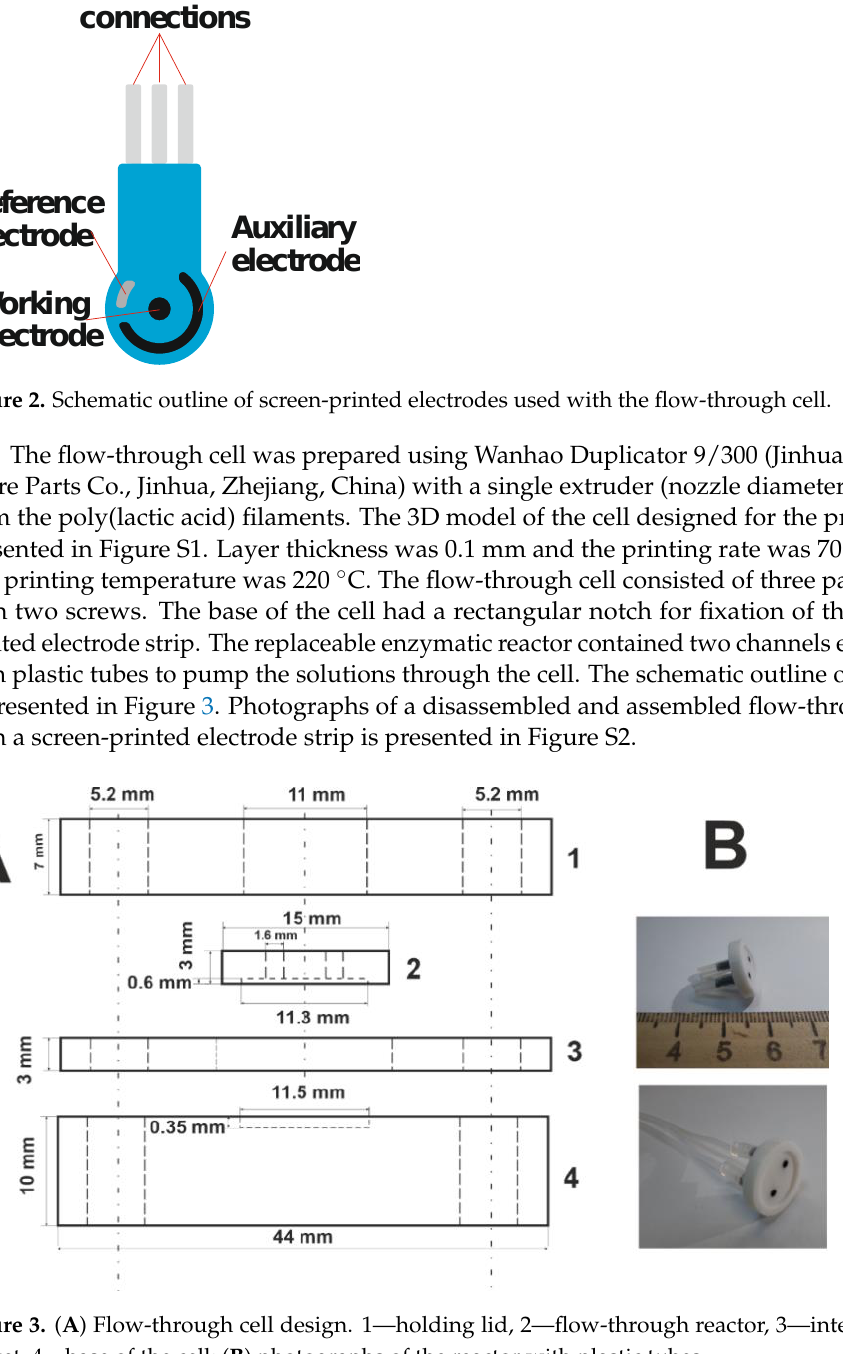
Figure 3. ( A ) Flow-through cell design. 1 — holding lid, 2 — flow-through reactor, 3 — intermediate gasket, 4 — base of the cell; ( B ) photographs of the reactor with plastic tubes.